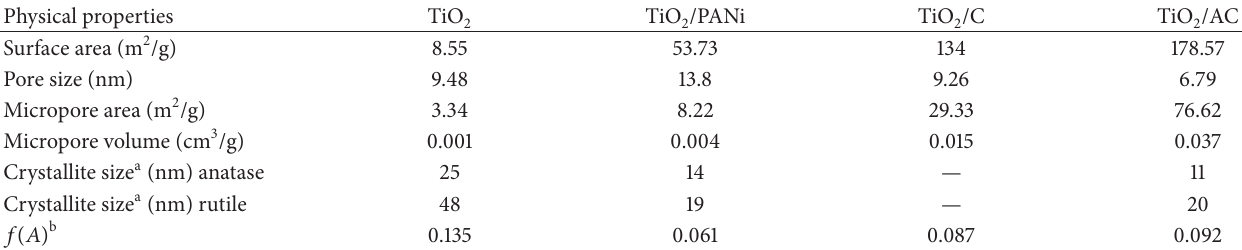
, TiO /PANi, TiO 2 2